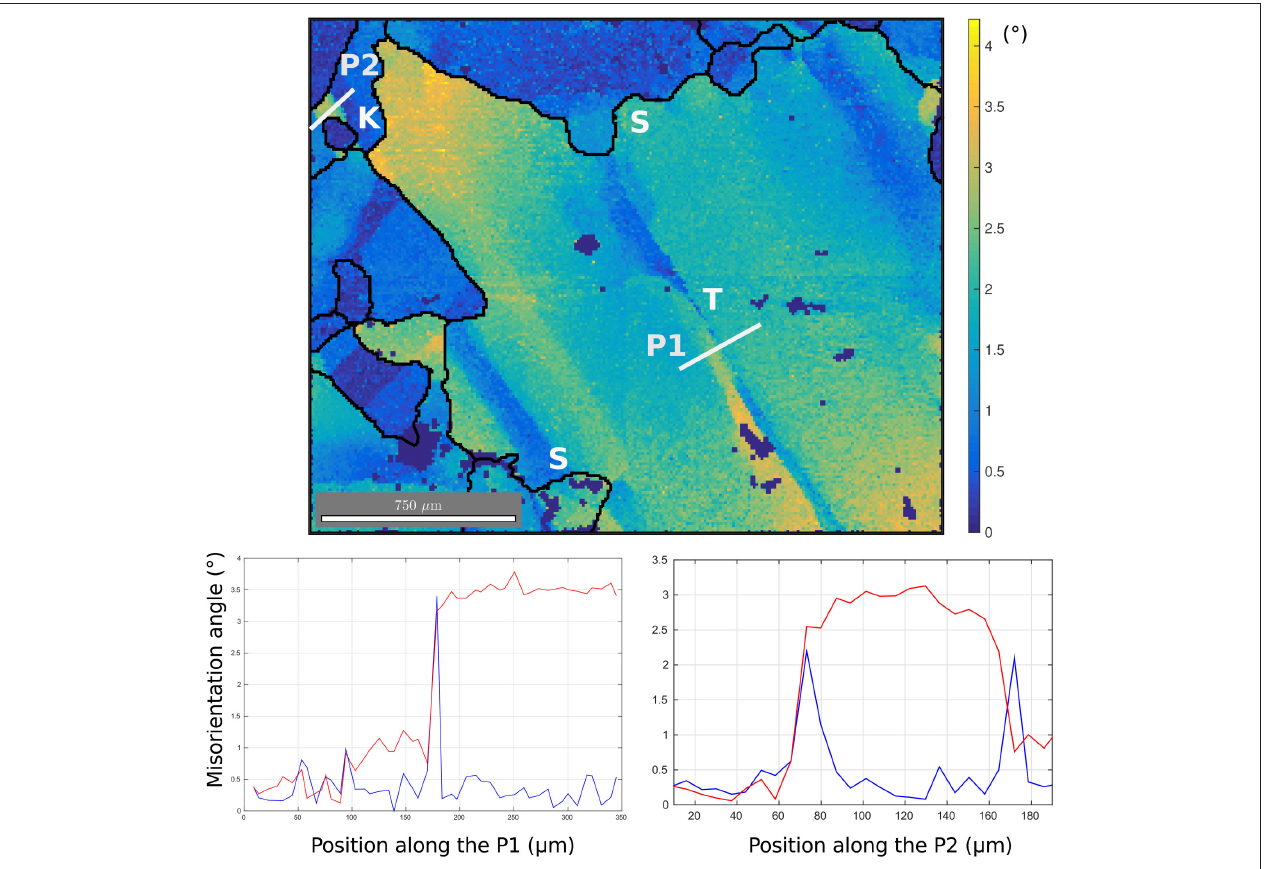
FIGURE 6 | Top: High resolution (5 µ m) observation of lattice misorientations at a triple junction in the sample deformed at 7% strain. Misorientation amplitudes compared to the average orientation of the grain (Mis2mean) are given by the color-scales in ◦ . The white lines are profiles across subgrain boundaries. Bottom: Misorientation along the two profiles P1 (left) and P2 (right). P1 represents a typical tilt band, while P2 is a kink band formed of two opposite tilt bands. “S” stands for “Serrated GB,” “K” for “kink band” and “T” for tilt